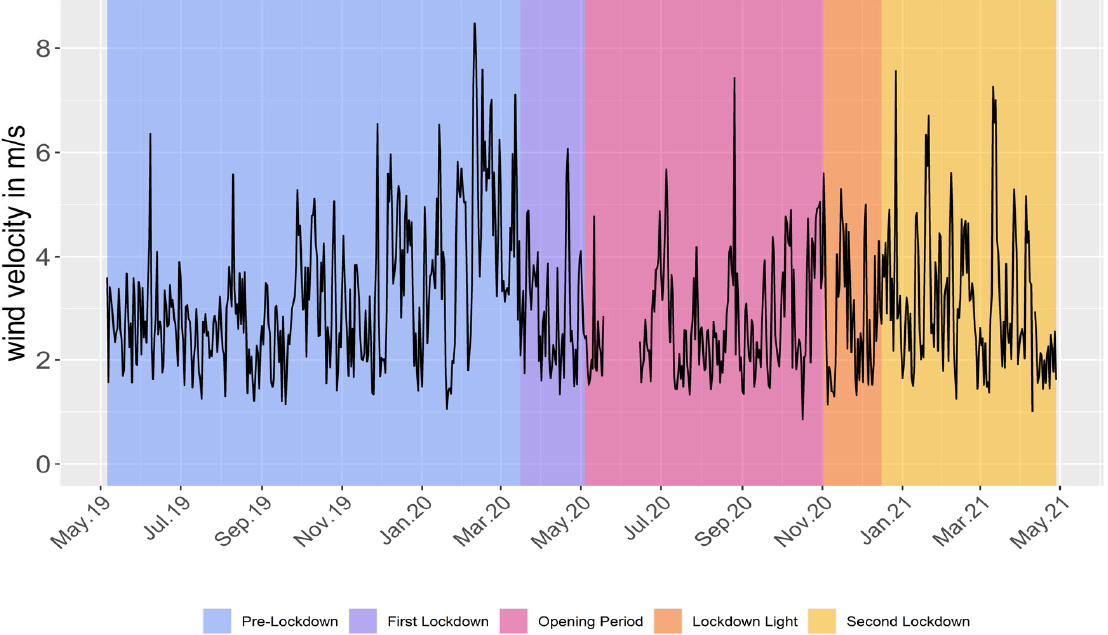
Figure A5. Daily means for wind in m/s over time. The missing parts from mid ‐ May to mid ‐ June 2020 are attributed to the devices not being in the field because of maintenance. For consistency, the wind data are also not depicted in this timeframe.